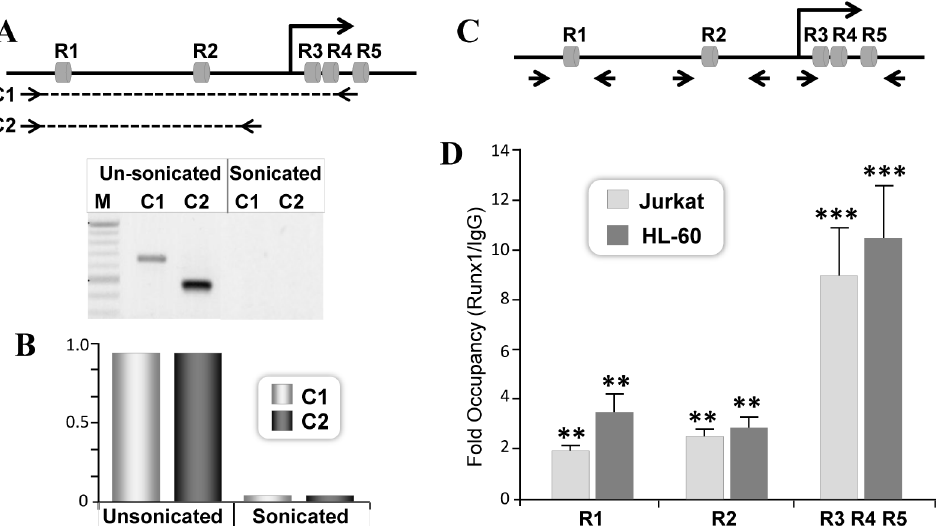
Fig 4. Endogenous RUNX1 protein is recruited to RUNX motifs located in the P1 promoter and the 5 ’ UTR. A) Efficiency of chromatin shearing of the RUNX1 locus in Jurkat cells. Control (unsonicated) and sheared (sonicated) chromatin was subjected to PCR using either (A) traditional or (B) real time qPCR analysis. Primer pair amplifying RUNX1 chromatin loci encompassing R1-R4 (C1) or R1-R2 (C2) is indicated with dashed lines. The amplified 650bp C1 and 500bp C2 region of the RUNX1 gene were detected in control but not in sonicated chromatin. M denote 100bp ladder. B) Lack of intact DNA between the promoter and the UTR RUNX sites in sonicated chromatin was confirmed by real time qPCR. C) Arrowhead indicates relative position of primer pairs used to assess RUNX1 occupancy on promoter and UTR RUNX motifs D) Equivalent amount of chromatin (3U OD260) from Jurkat or HL-60 cells were used for ChIP assays. Chromatin was immunoprecipitated with 2 μ g of IgG or RUNX1 polyclonal antibody. Site specific occupancy was determined by real time PCR. Mean values of IgG or RUNX1 immunoprecipitated DNA from three independent experiments with three replicates were obtained for each site. Data is expressed as fold changes over IgG in respective cells. Asterisks indicate statistically significant enrichment of DNA immunoprecipitated with RUNX1 antibody ( ** p < 0.01, *** p < 0.001).